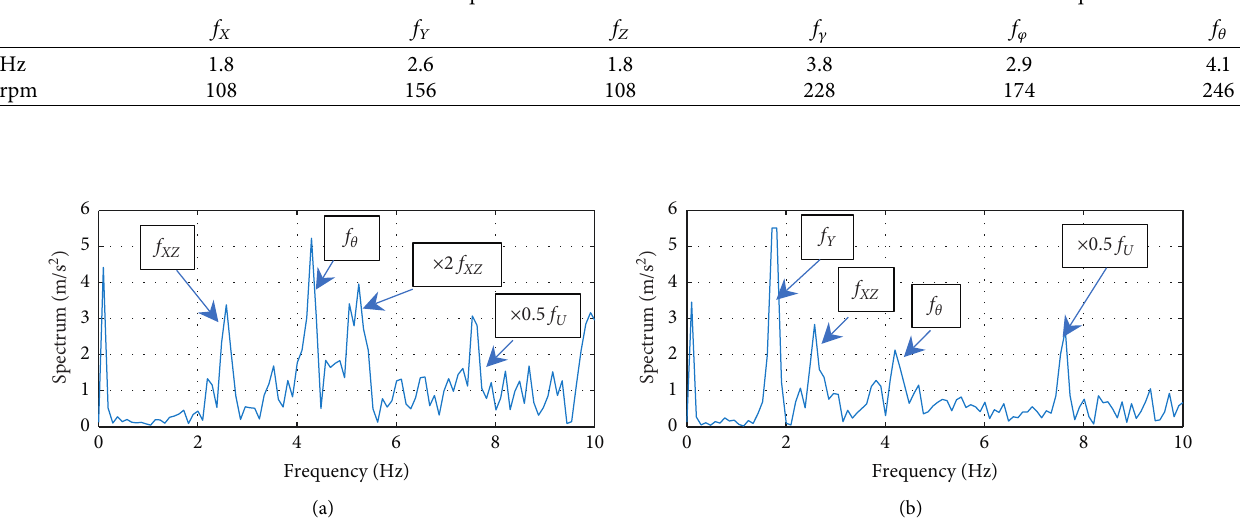
Figure 14: Spectrums of low-frequency vibration on the right side of the upper (a) and down (b) springs.